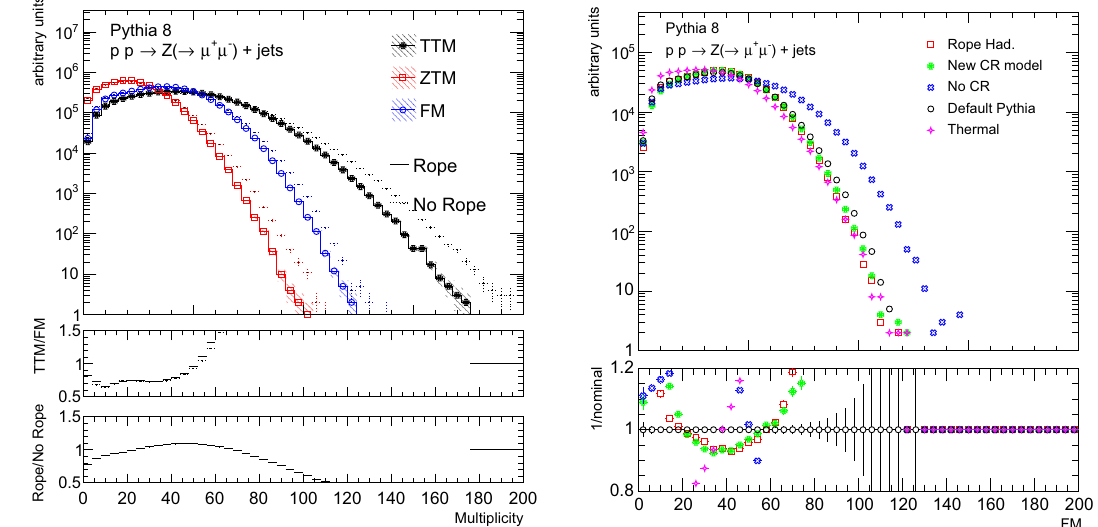
Fig. 2 Left: The distribution of the three definitions of multiplicity before for the default and Rope hadronization models. Right: a comparison of the FM for the various models described in Sect. 2.1 if they are within an annulus of (cid:6) R < 0 . 6 around the signal jet